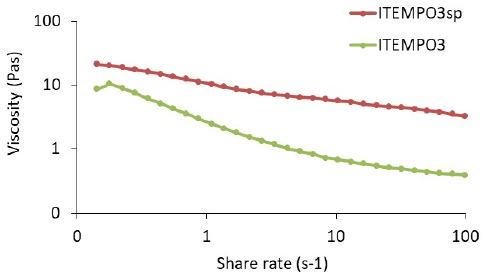
Figure 7. Rheological study (shear rate vs. viscosity) of the new formulated conductive inks.